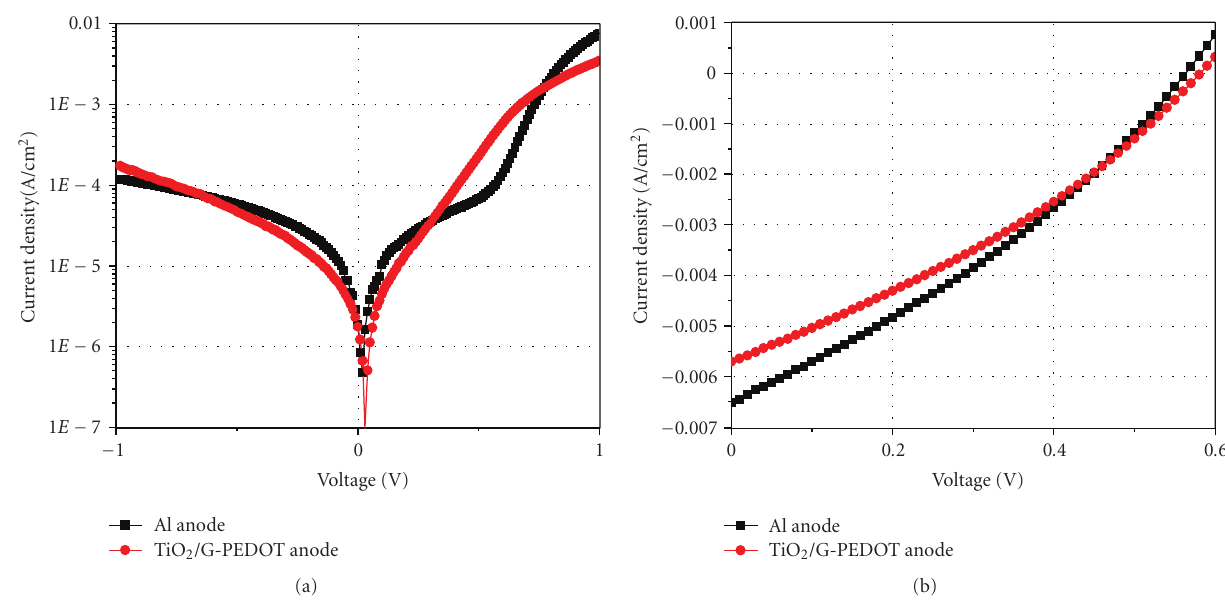
Figure 6: I–V characteristics of ITO/PEDOT/P3HT+PCBM/TiO 2 /Al (square), and ITO/TiO 2 /P3HT+PCBM/TiO 2 /G-PEDOT (circles). (a) I–V characteristics of device in dark condition, (b) I–V characteristics measured under white illumination (Xe lamp, 80mW/cm 2 ). Devices’ performance: (square) Jsc = 6.5mA/cm 2 Voc = 0.58 V FF = 0.32 η = 1.5%, (circles) Jsc = 5.7 mA/cm 2 Voc = 0.59V FF = 0.33.